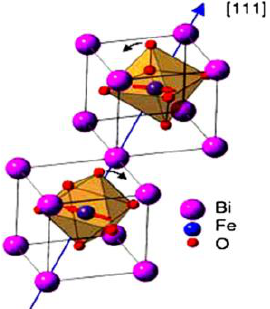
Figure 2 . Bismuth ferrite unit in the perovskite structure [8].